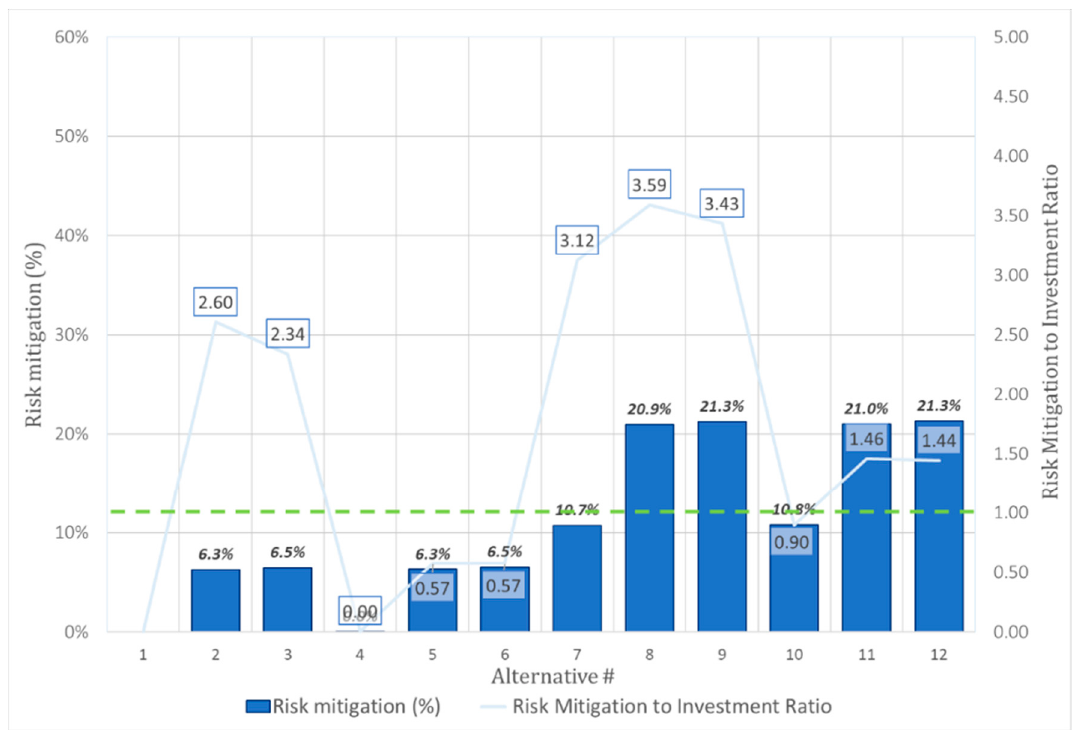
Figure 5. Analysis of the mitigation alternatives by the percentage of risk mitigation and RMIR case of the Be’er Sheva region.